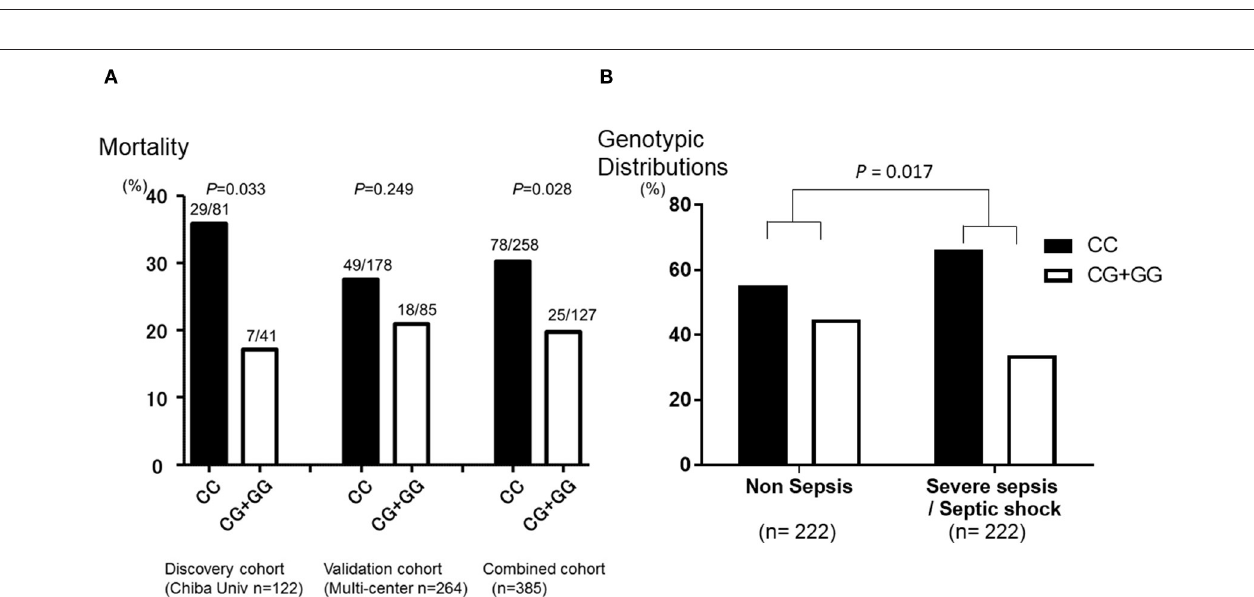
FIGURE 2 | Mortality and morbidity of severe sepsis in genotype categories of thrombomodulin gene (THBD) single nucleotide polymorphisms (SNPs) rs2239562. (A) The Y -axis of the graph shows the mortality of severe sepsis in the SNPs that is in the promoter region of THBD ( − 1920*C/G; rs2239562). The patients with the CC genotype of rs2239562 were significantly associated with worse outcome of severe sepsis than the CG + GG genotype of the SNP in the discovery cohort ( P = 0.033). The trend was maintained in the validation cohort ( P = 0.249), and the association was strengthened in the combined cohort ( P = 0.028). (B) The Y -axis of the graph shows the genotypic distributions of the SNP that is in the promoter region of THBD ( − 1920*C/G; rs2239562) in the patients with severe sepsis and without any evidence of sepsis (non-sepsis). The percentage of patients with the CC genotype of rs2239562 was significantly higher in the SS group than those in the non-sepsis group ( P = 0.017). The P values for the SNP were evaluated with the chi-square test on the dominant model analysis with the correlation/trend